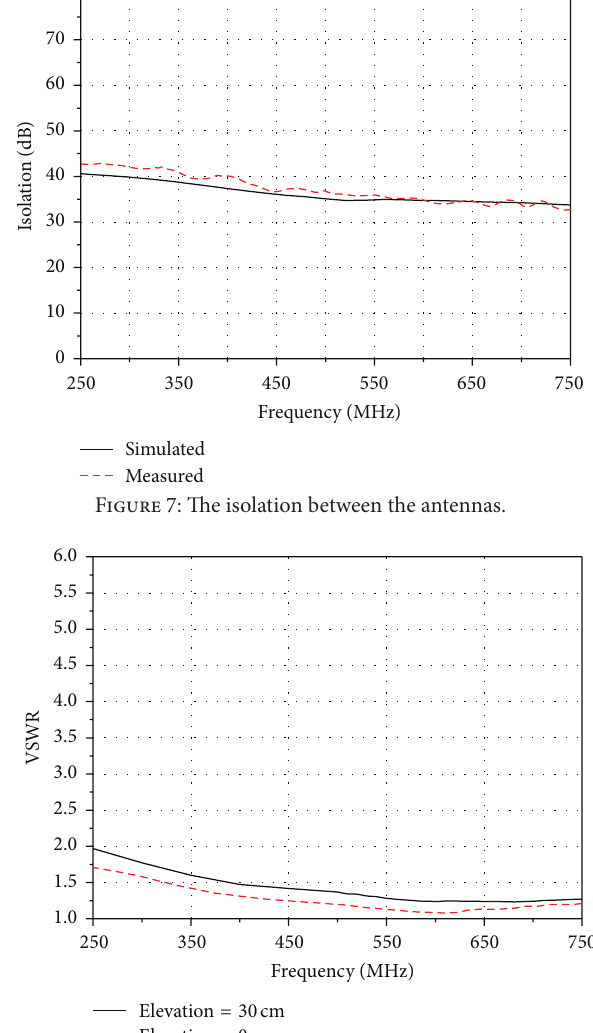
Figure 7: The isolation between the antennas.